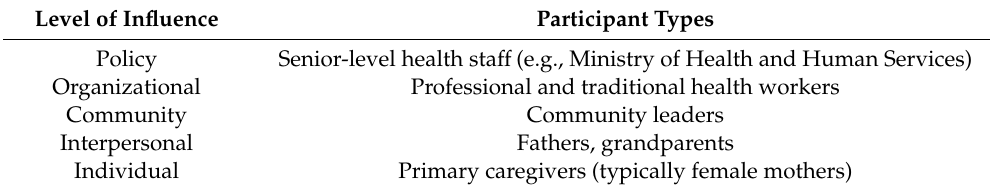
Table 2. Initial sampling framework with participant types by level of influence.